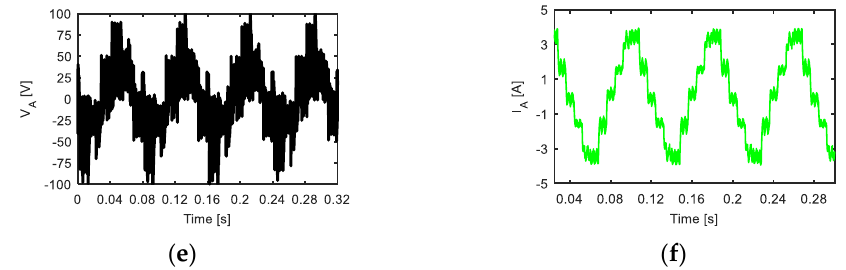
Figure 10. ( a – c ) Simulated and ( d – f ) measured results for a 12.5 Hz output frequency, ( a , d ) line